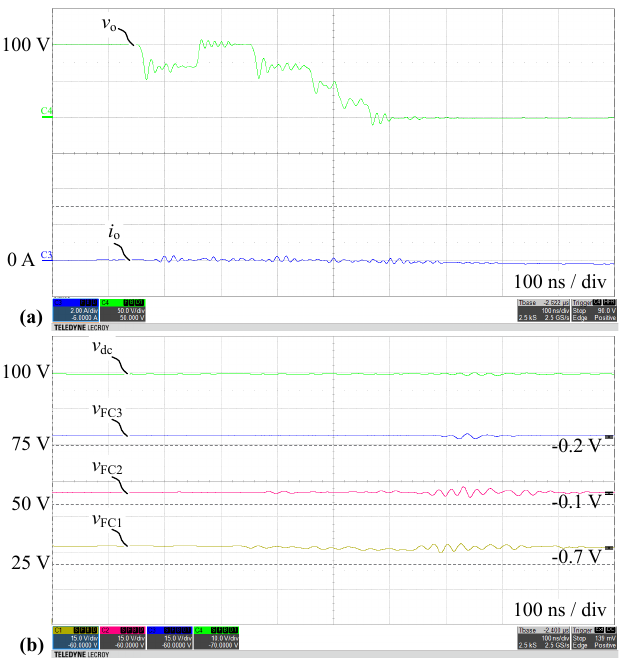
Figure 13. Measured waveforms for Q2L-5L-FCC in configuration 2 (cid:13) with zero output current ( I o = 0A) during the switching transition with negative slope of v o and CMS sequence SEQ 1(11)234 (events in cells ‘1000’): ( a ) Output voltage v o and current i o , ( b ) DC-link capacitor voltage v dc and FC voltages v FC{1,2,3} . Delay times and pulse time T delay = T p = 50ns are used. Figure 15 presents measured waveforms for full DC-link configuration with OL balancing during a negative load step from 100% to 67% of the nominal load ( I o = 4.6 A